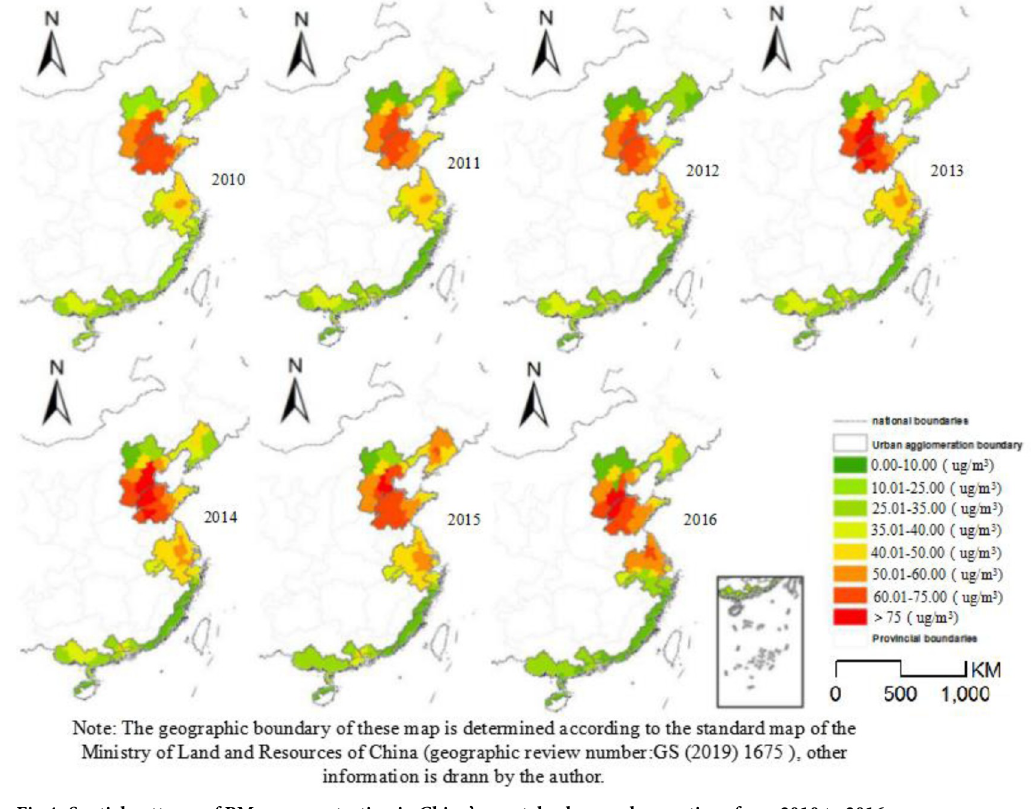
Fig 4. Spatial patterns of PM 2.5 concentration in China’s coastal urban agglomerations from 2010 to